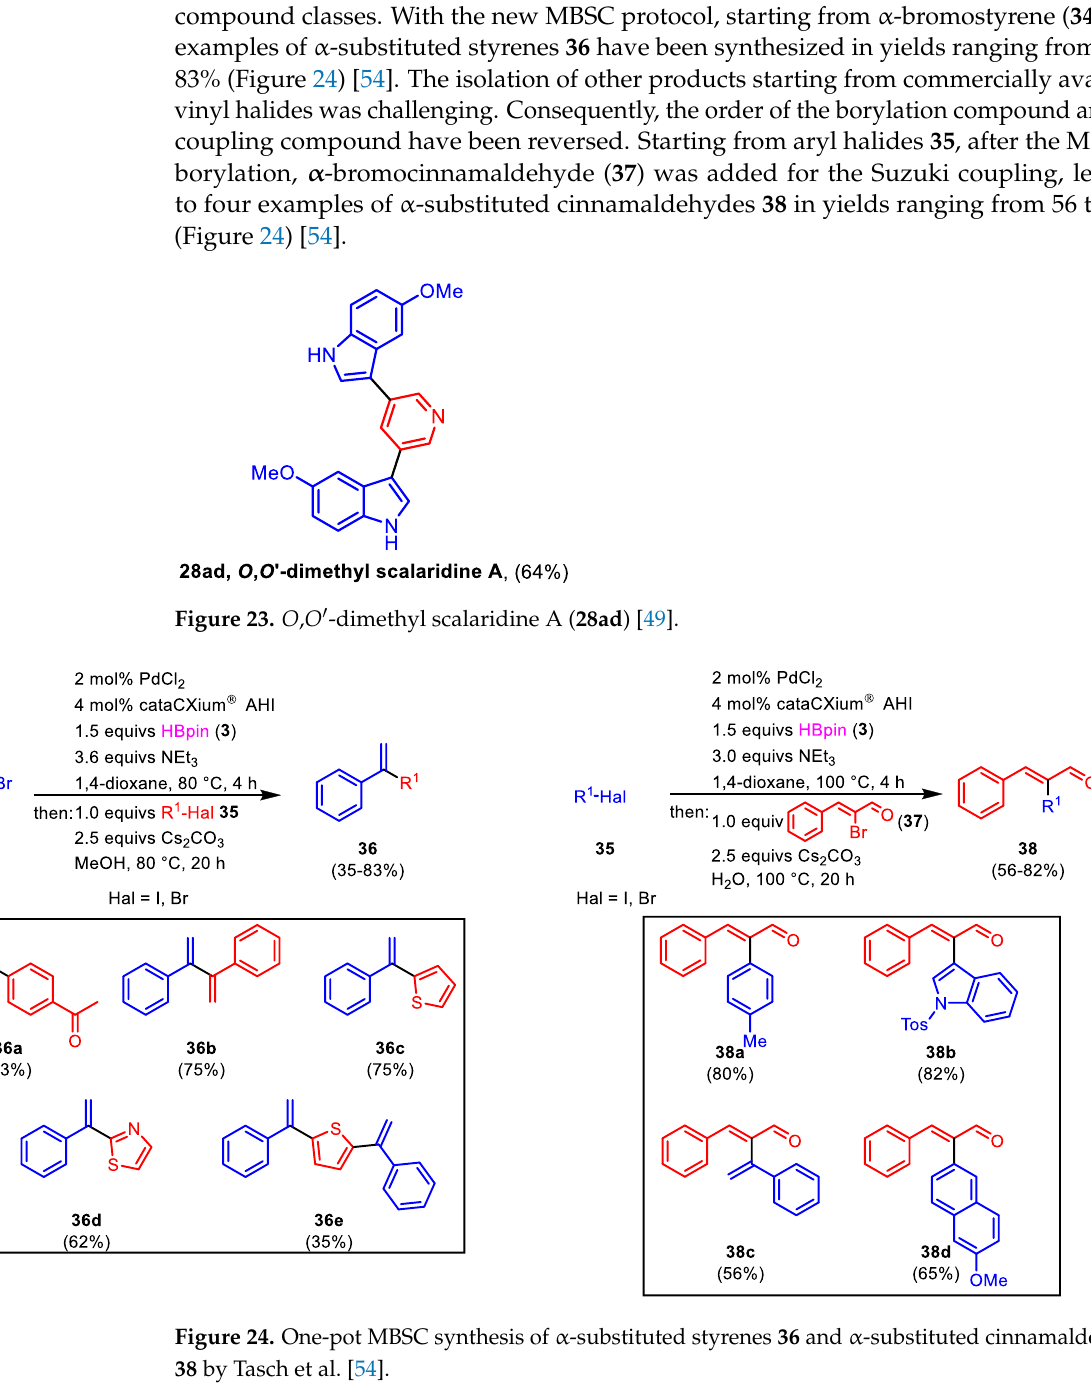
Figure 24. One- pot MBSC synthesis of α -substituted styrenes 36 and α -substituted cinnamalde- hydes 38 by Tasch et al. [54]. During the synthesis of cinnamaldehydes 38, the reactivity of their Michael system is maintained, leading to complex building blocks for further functionalization. Therefore, Tasch et al. envisioned that the sequentially palladium-catalyzed MBSC sequence can be expanded for a concluding cyclocondensation with tosylhydrazine ( 39 ) leading to a con- secutive three-component synthesis of pyrazoles 40 . With this extended sequence, seven